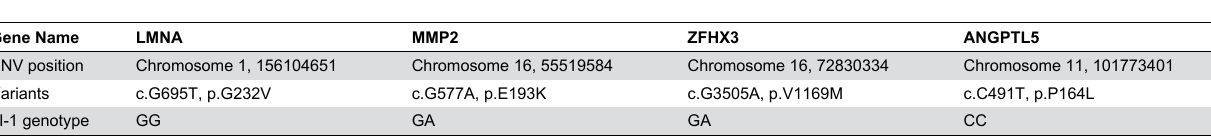
Table 5. Candidate SNVs for a causal mutation in the